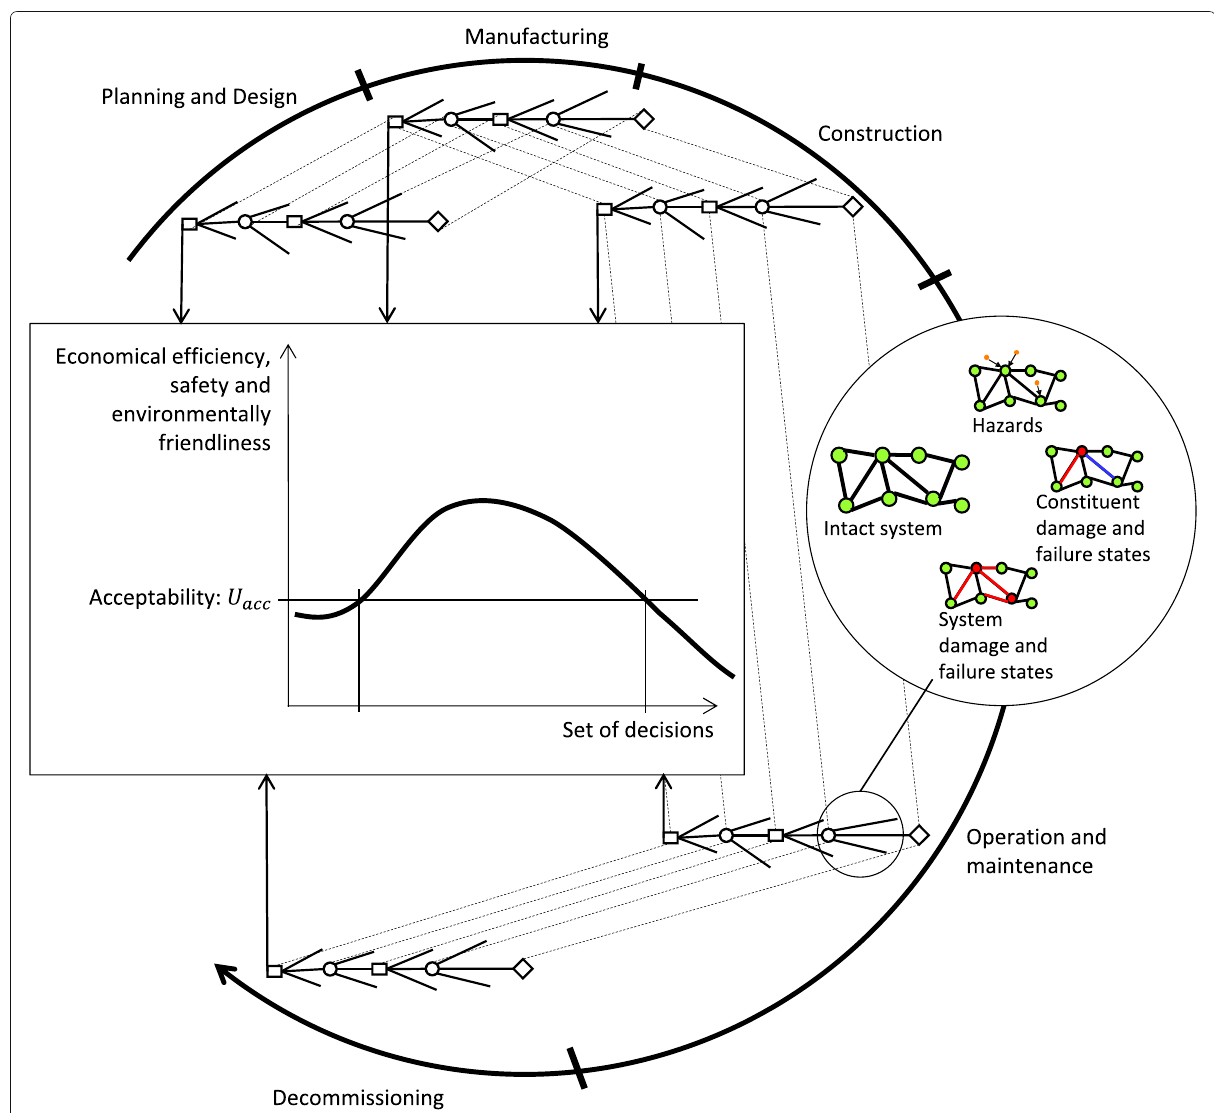
Fig. 8 Illustration of a value of SHI analyses throughout the life cycle phase [94]